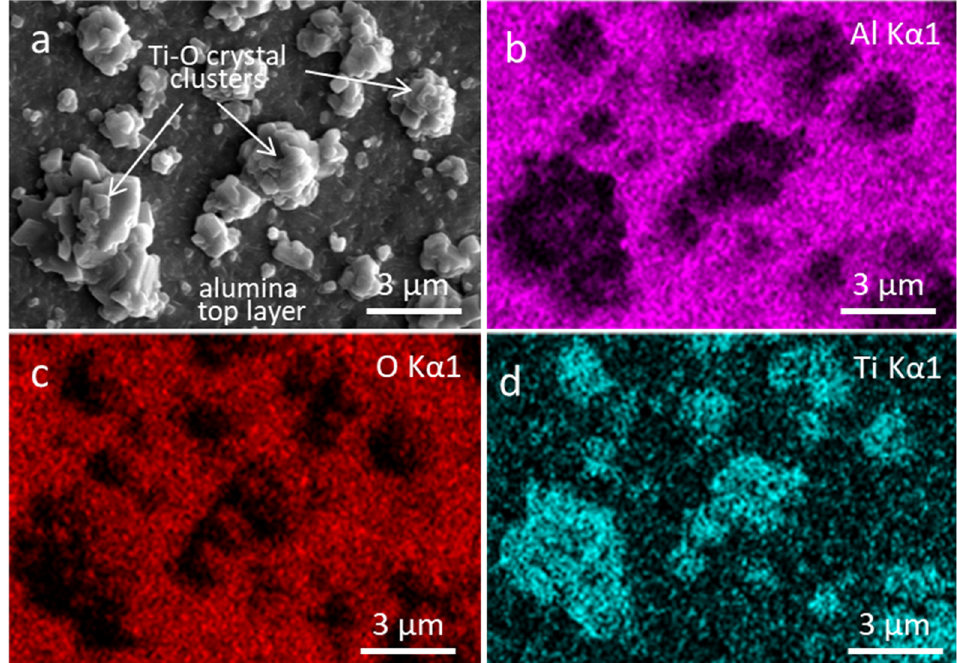
Figure 11. Top-view SEM image of the surface of the TiAlN coating oxidized at 850 °C for 60 min ( a ) and the corresponding elemental maps ( b – d ). and the corresponding elemental maps ( b – d